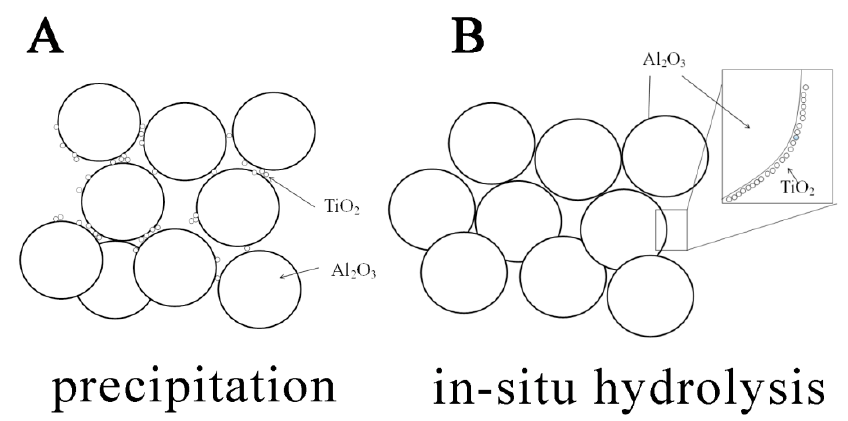
Figure 3. The proposed distribution of nano TiO 2 in porous alumina supports prepared by ( A ) precipitation and ( B ) in-situ hydrolysis.